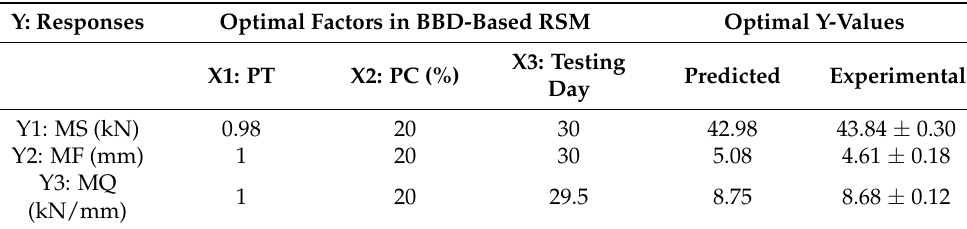
Figure 16. Optimization values of responses vs. multiple variables using RSM. Table 5. Optimal prepared factors values in BBD-based RSM (predicted) and